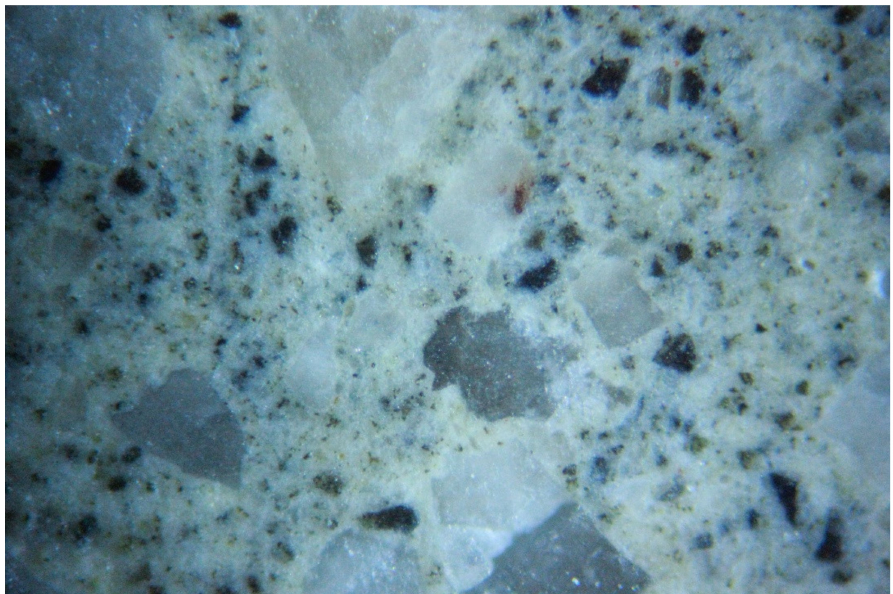
Figure 13. Specimen E after exposure to 400 ◦ C under a polarization microscope (BK-POLR, magnifi- cation 100 ×